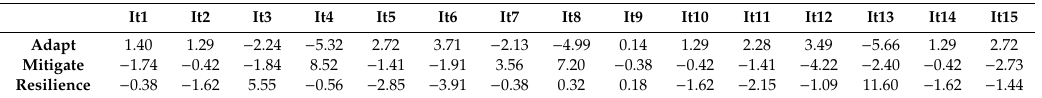
Table 8. Residuals of data for Benin.